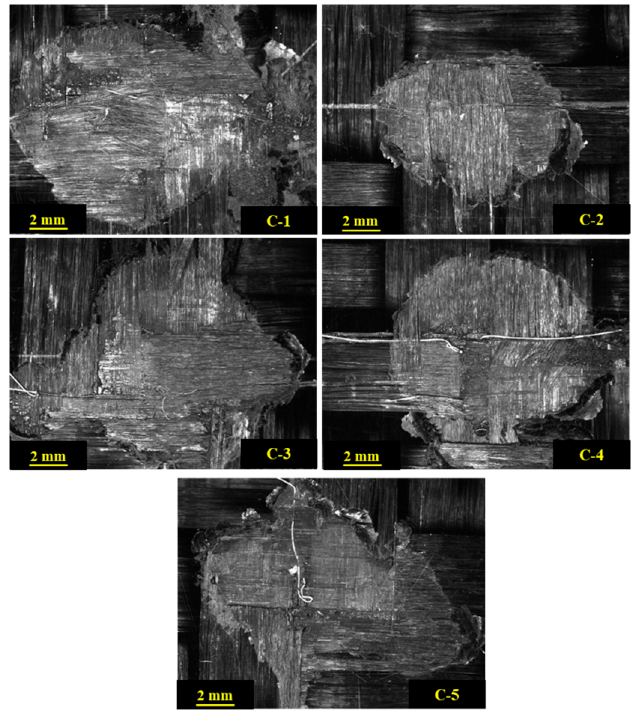
Figure 14. Microscopic images of the fracture surfaces (at the weld plane B–B) of the controlled weld spots. An exemplary fracture surface was chosen from each controlled weld case (images taken with a resolution of 1024 × 768 pixels using a stereo-microscope with a magnification of 2 × ).